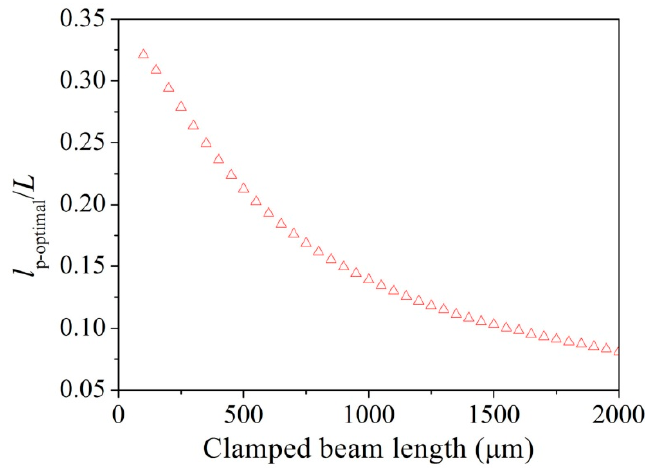
Figure 4. Evolution of the l p-optimal / L as a function of the clamped beam length ( L ).